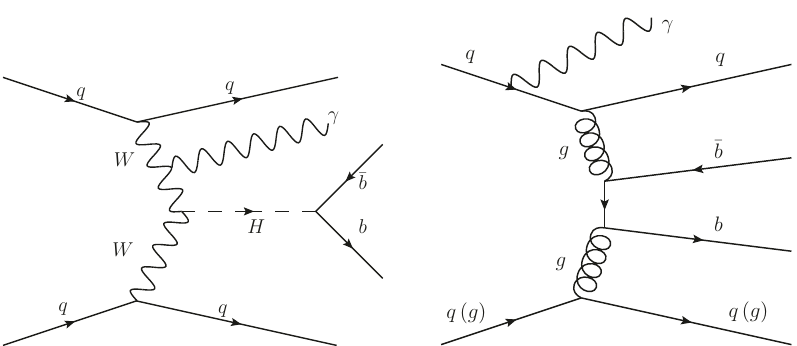
Figure 1 . Representative leading-order Feynman diagrams for Higgs boson production via vector- boson fusion in association with a photon (left) and the dominant non-resonant b (cid:22) b(cid:13)jj background